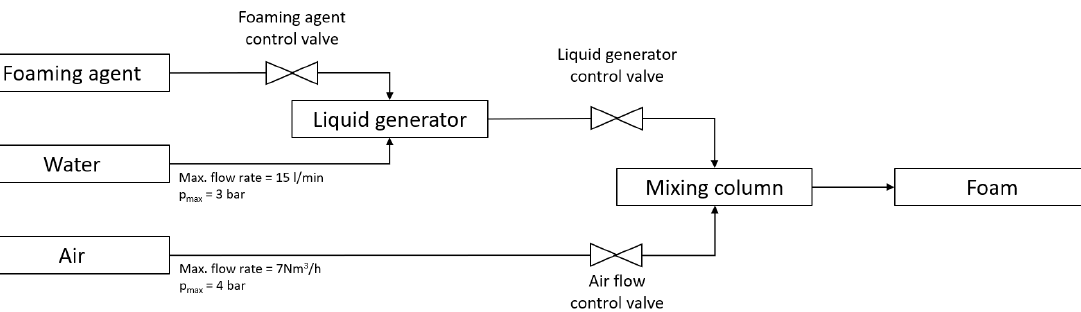
Figure 2. Foam generation scheme.